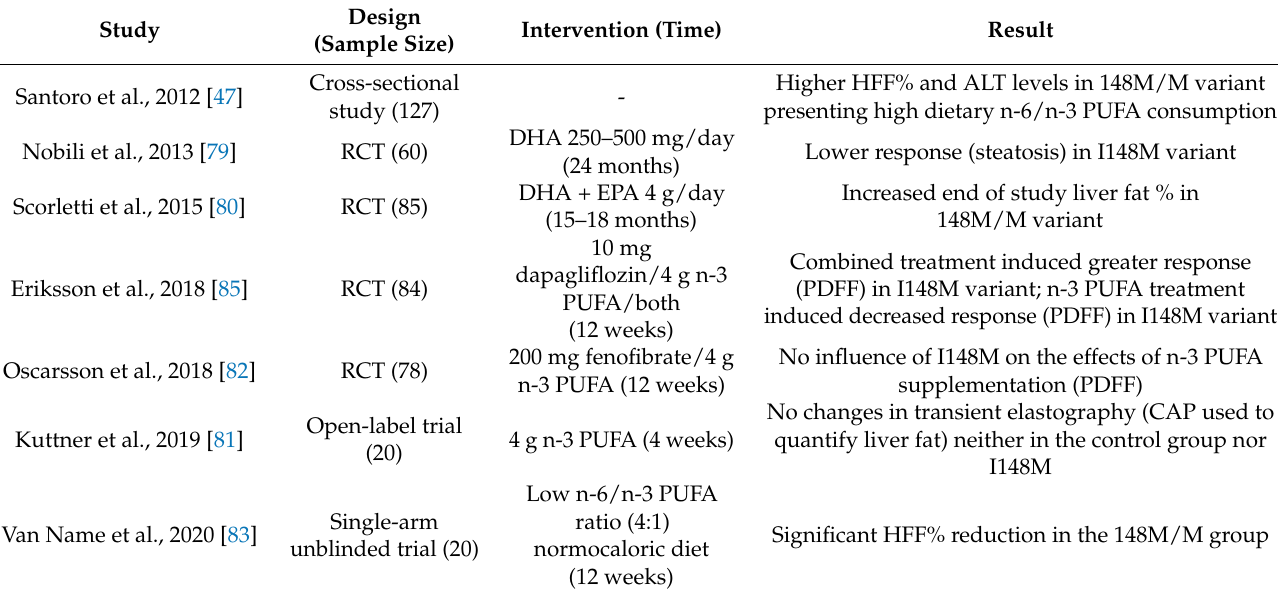
Table 1. Clinical studies assessing the role of the interaction between omega-3 PUFA and PNPLA3 rs738409 in NAFLD.